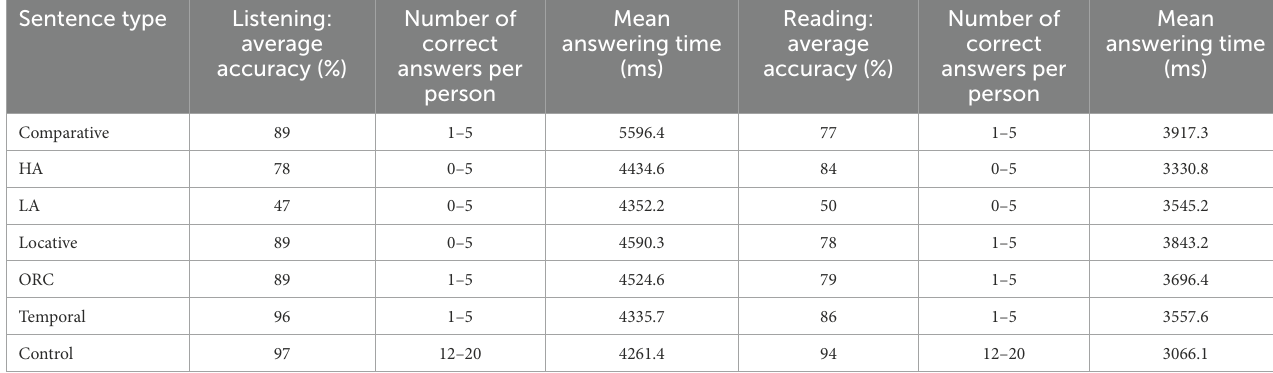
TABLE 7 Average question answering times and accuracy in the reading and listening modes in Experiment